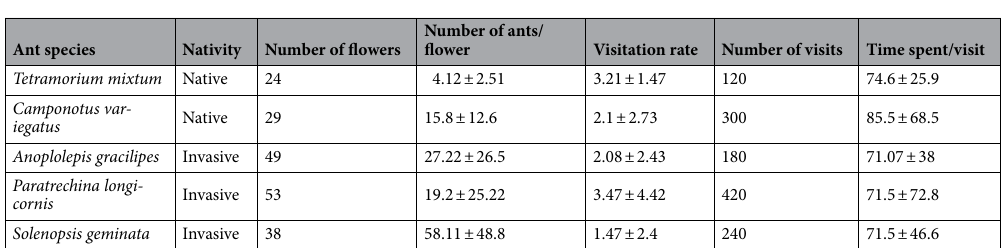
Table 1. Number of ants, visitation rate of pollinators and time spent per visit by the pollinators on flowers occuped by different species of ants.